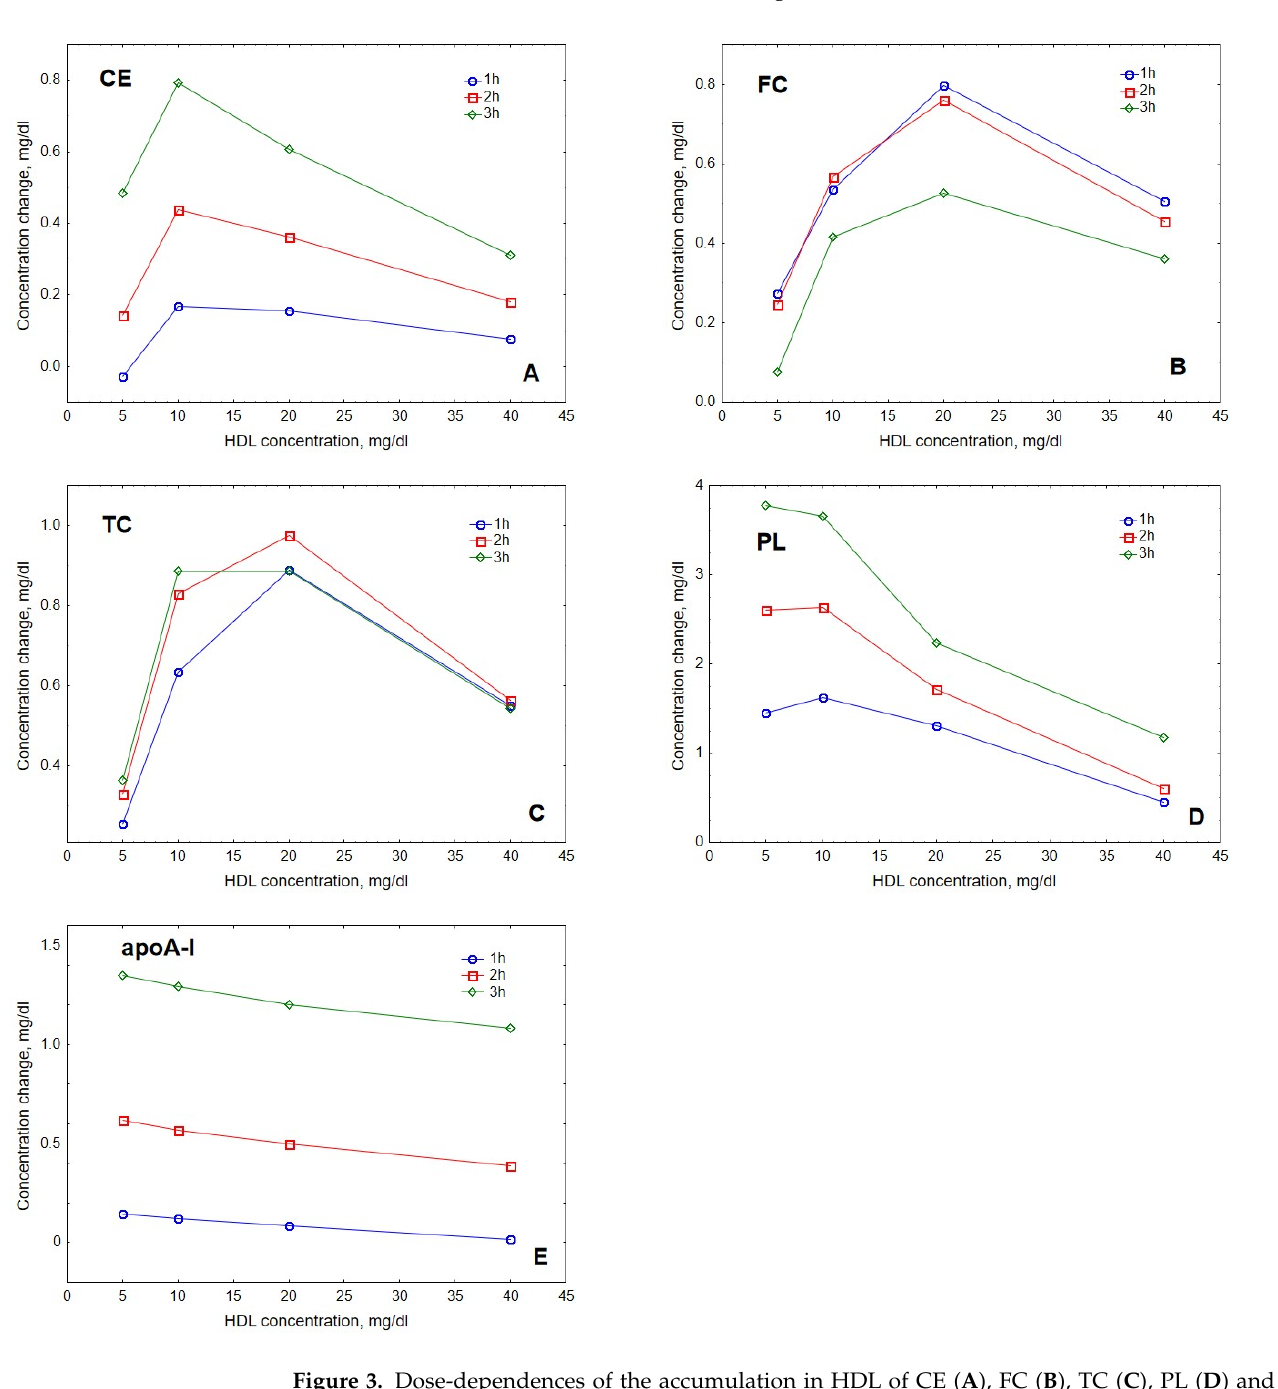
Figure 3. Dose-dependences of the accumulation in HDL of CE ( A ), FC ( B ), TC ( C ), PL ( D ) and apoA-I ( E ) during VLDL lipolysis by LPL in the presence of HDL. Mathematical modelling was performed under conditions of in vitro TGRL lipolysis described elsewhere [25] for the reaction time of 1 (blue circles), 2 (red squares) and 3 (green diamonds) h. In order to calculate accumulation in HDL of a given component, its content at baseline (t = 0) was subtracted from the results of the modelling. Initial concentrations: HDL, 5, 10, 20 and 40 mg total mass/dL; VLDL-TG, 30 mg/dL; LPL, 190